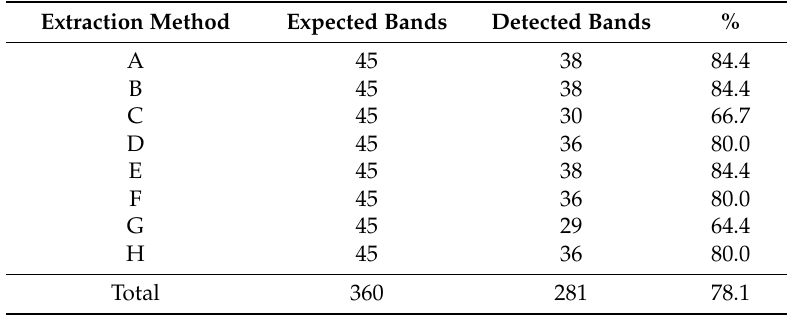
Table 2. Frequency analysis of the number of detected bands by PCR; A—DNeasy Blood and Tissue Kit (Qiagen), B—DNeasy mericon Food Kit (Qiagen), C—Chemagic DNA Tissue 10 Kit